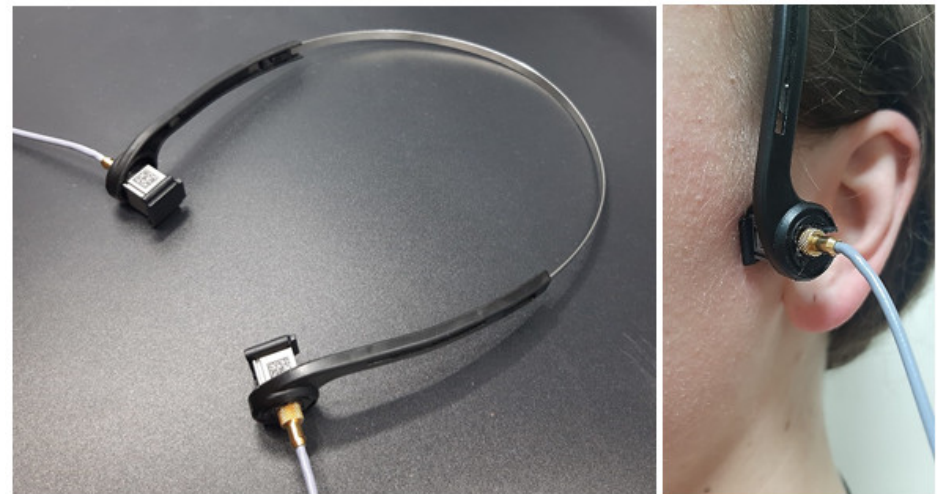
Figure 2. Sensors and their placement on the subject’s